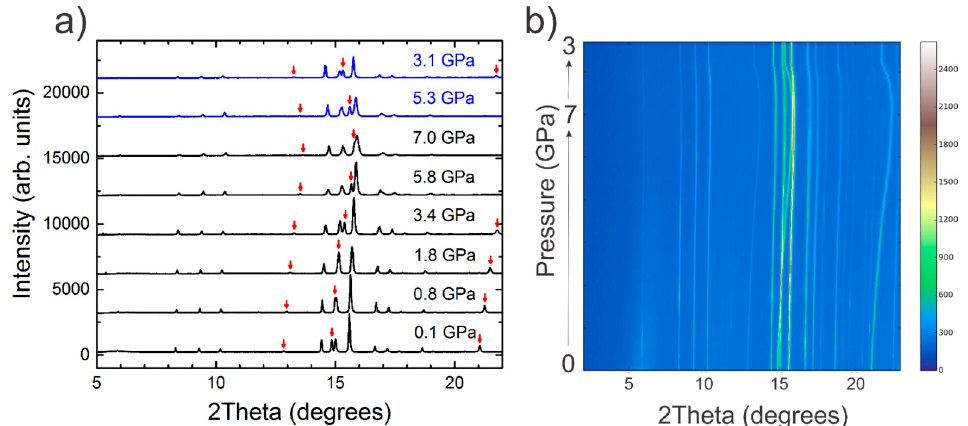
Figure 3. Selected room temperature synchrotron X-ray powder diffraction patterns are shown for various pressures ( a ) upon compression (black) and decompression (blue). The main peaks of the NaCl standard are indicated by red arrows; a contour plot of the collected diffraction patterns is shown in ( b ). White is the highest peak intensity and blue is the lowest.